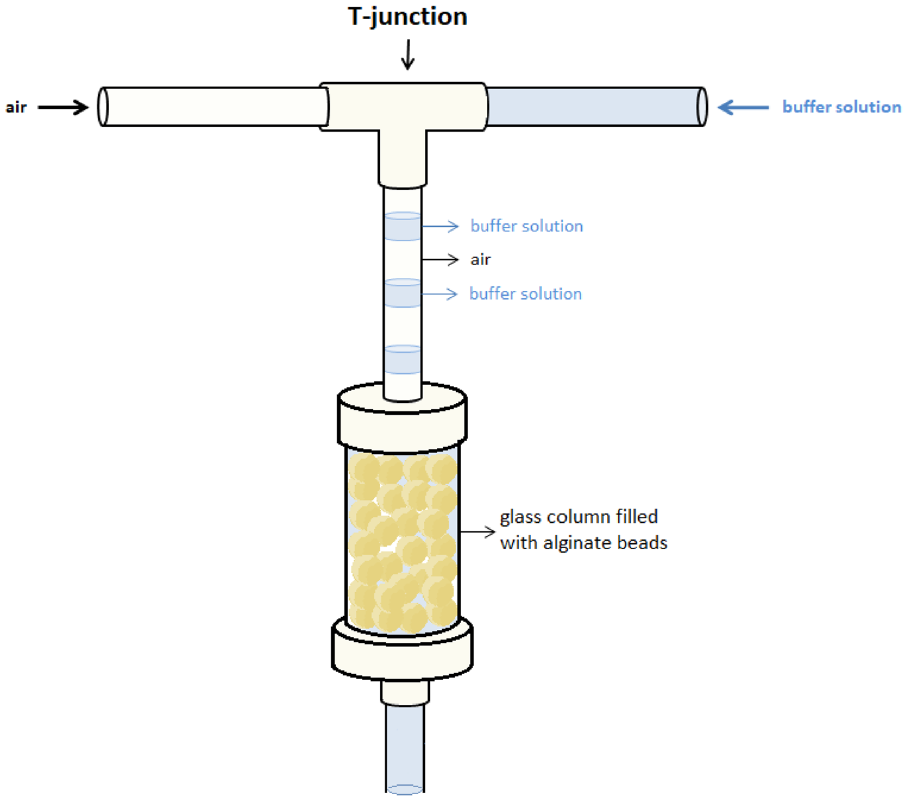
Figure 6. Scheme of packed-bed bioreactor with the segmented gas–liquid flow applied in